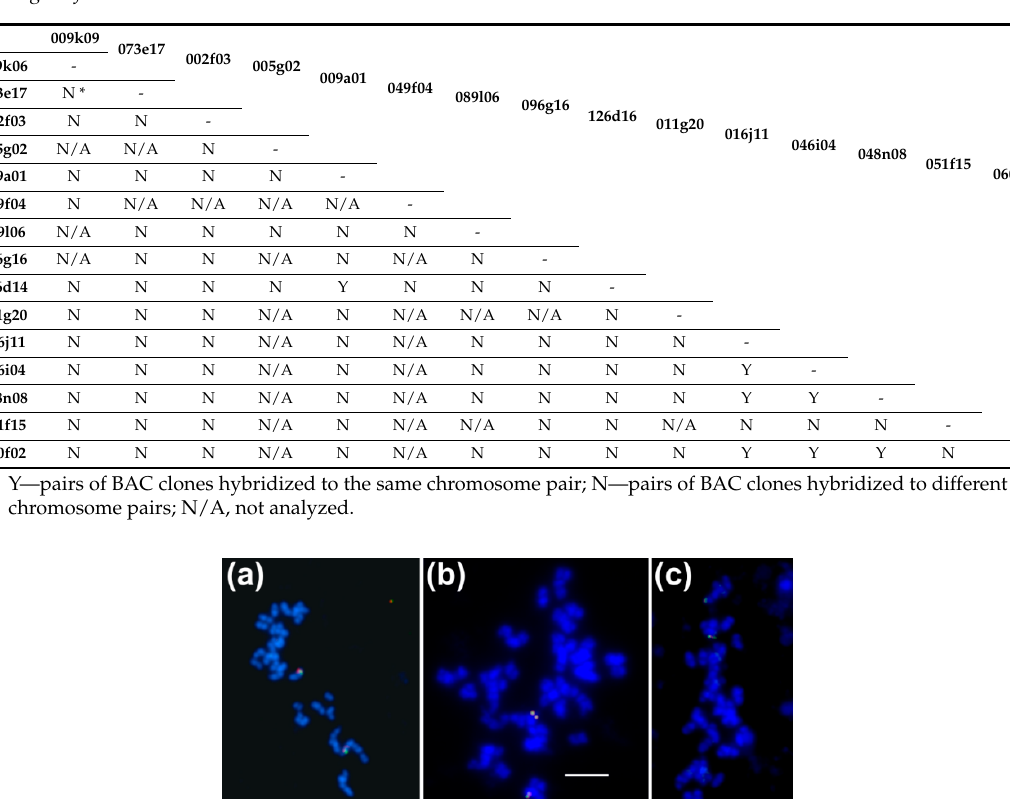
Table 2. Direct visualization of bacterial artificial chromosome (BAC) clones distribution in Lupinus angustifolius chromosomes.